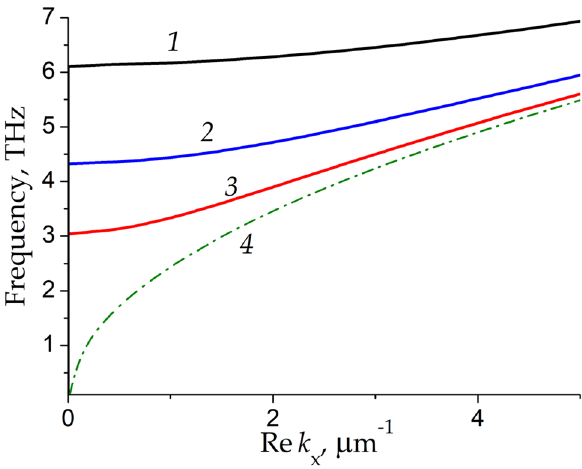
Figure 2. Dispersion of the LSM plasmon modes in the rectangular metal groove waveguide with active graphene for three different groove widths L = 0.5 μm, 1 μm, and 2 μm corresponding to curves 1 , 2 , and 3 , respectively, and TM plasmon mode dispersion in the infinite graphene sheet with a metal screen (dash-dotted curve 4